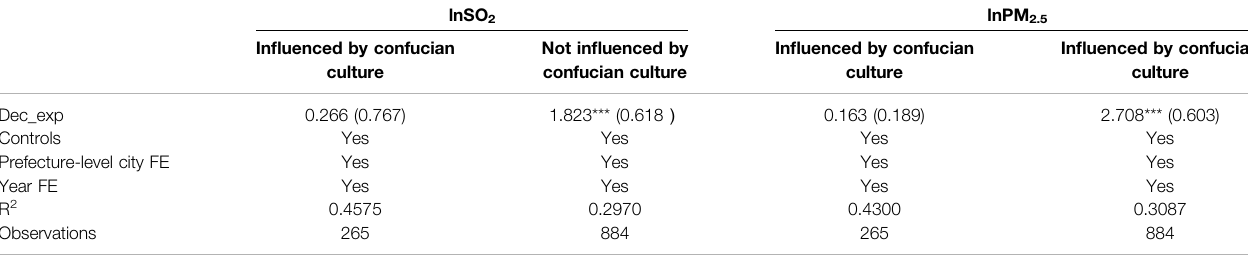
TABLE 7 | Results of the regions affected and not affected by Confucian